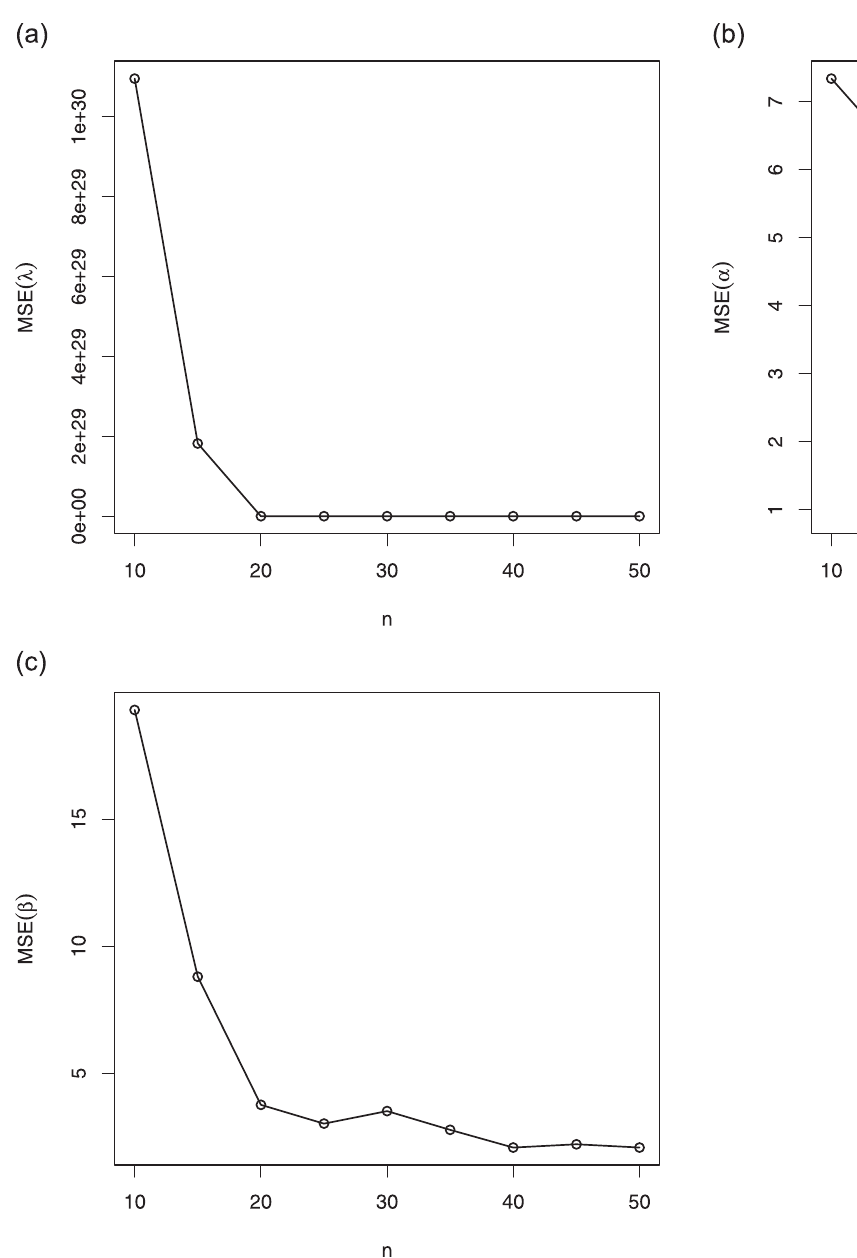
Fig 4. Plots of the empirical MSEs of the TSW model parameters for S